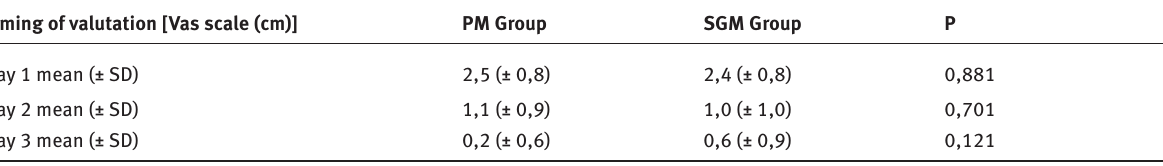
Table 4a: VAS Scale evaluation